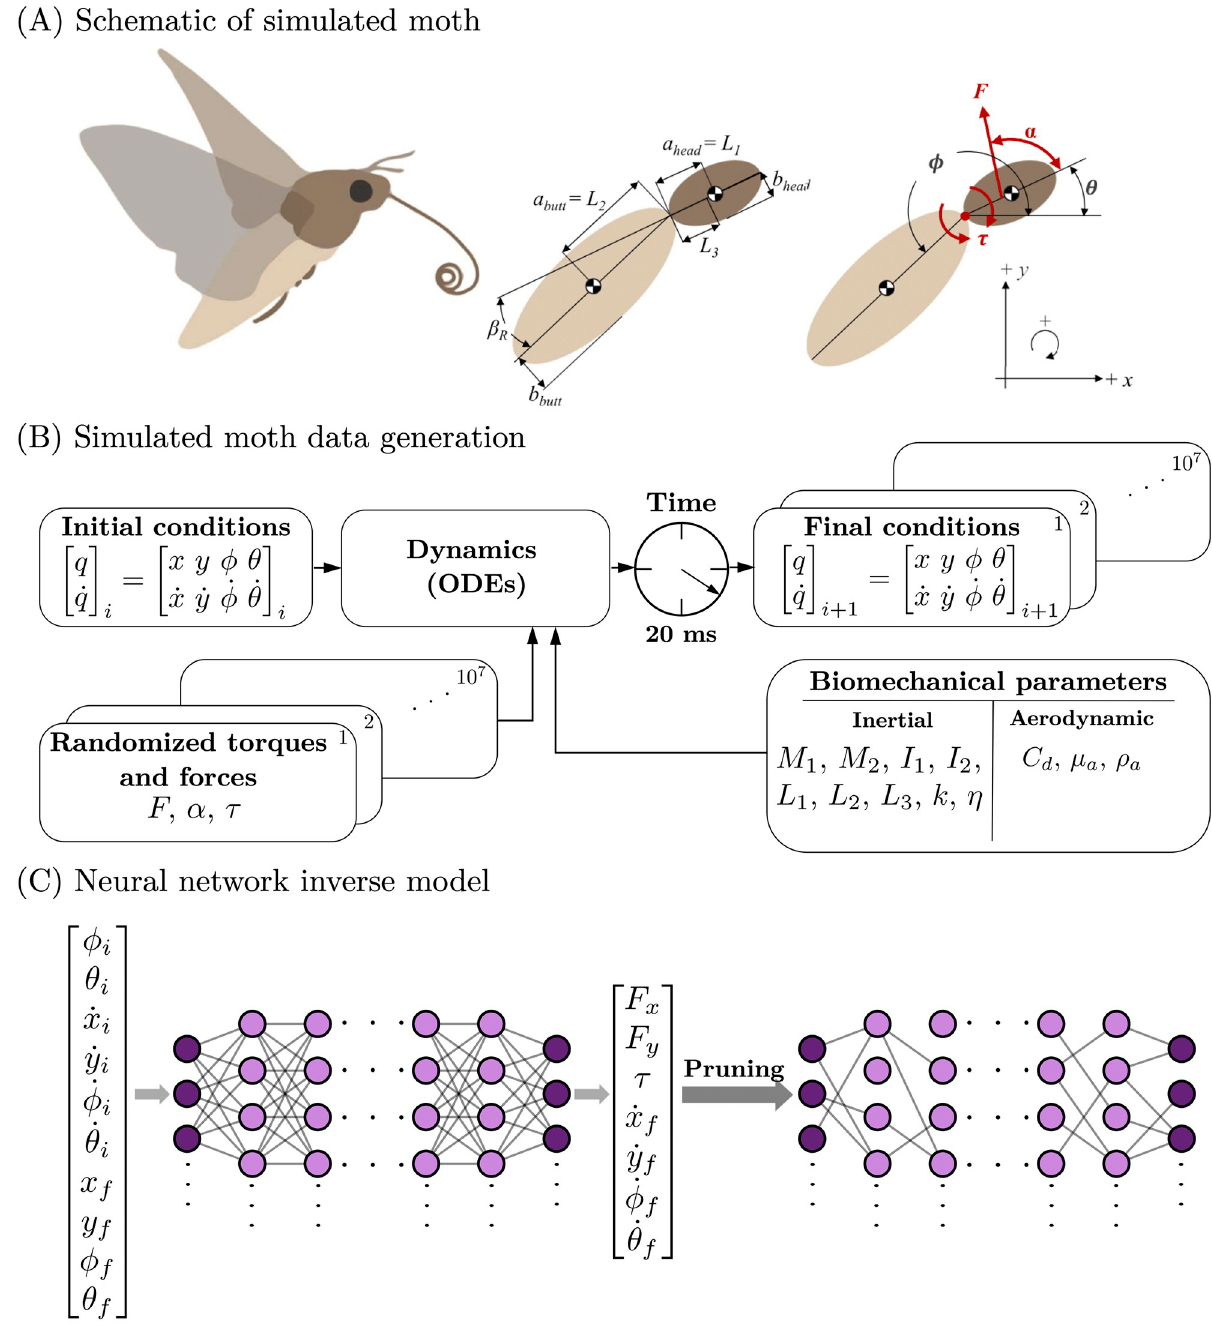
Fig 1. Inverse problem of flight control. (A) The moth body is made of two ellipses attached with a spring. There are three control variables ( F , α , and τ ) and four parameters to describe the state space ( x , y , θ , and ϕ ). See S1 Table for the global parameters and S2 Table for the calculated variables. (B) The differential equation solver solves the forward problem of insect flight control. (C) The neural network is an attempt to solve the inverse problem of flight